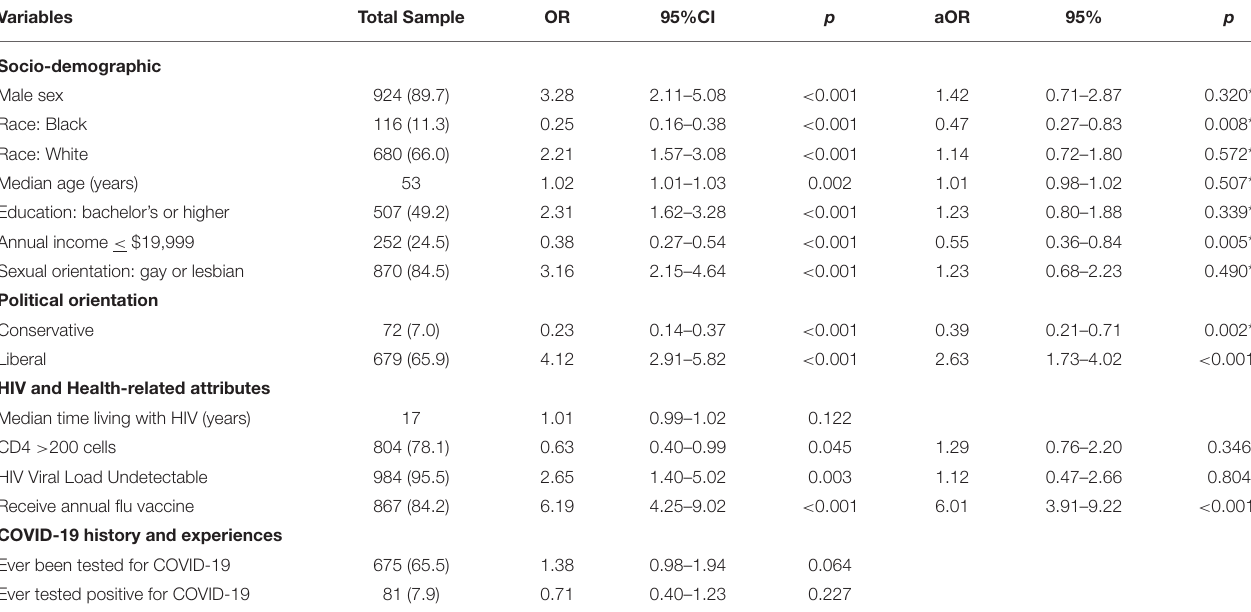
TABLE 1 | Bivariate and multivariable logistic regression of COVID-19 vaccine willingness ( N = 1,030). Variables